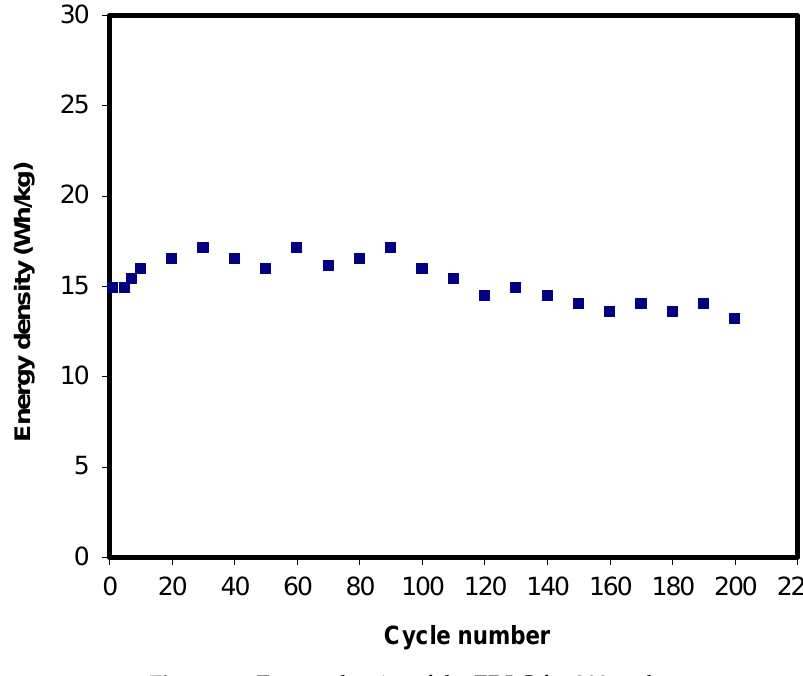
Figure 10. Energy density of the EDLC for 200 cycles.